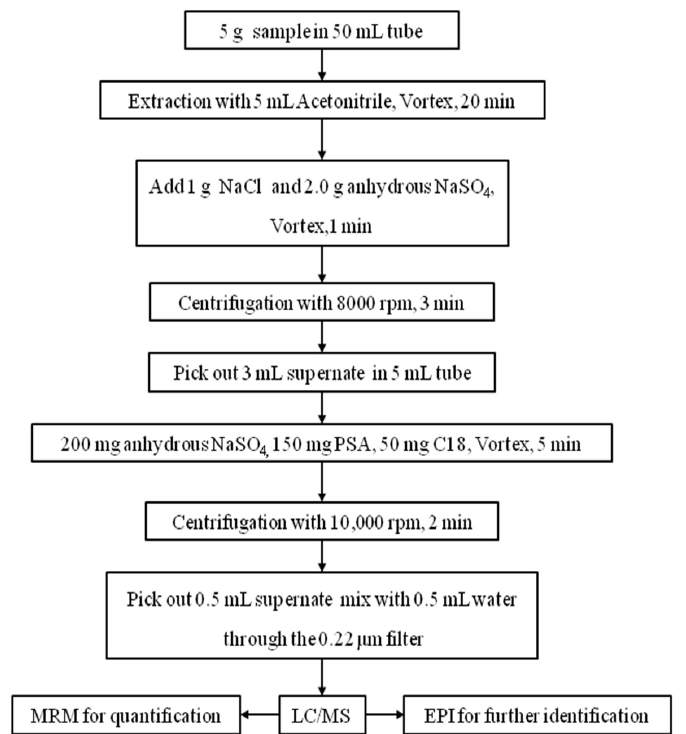
Figure 1. Scheme of analysis for the simultaneous determination and identification of fifteen carbamate pesticide residues in multi-matrices.